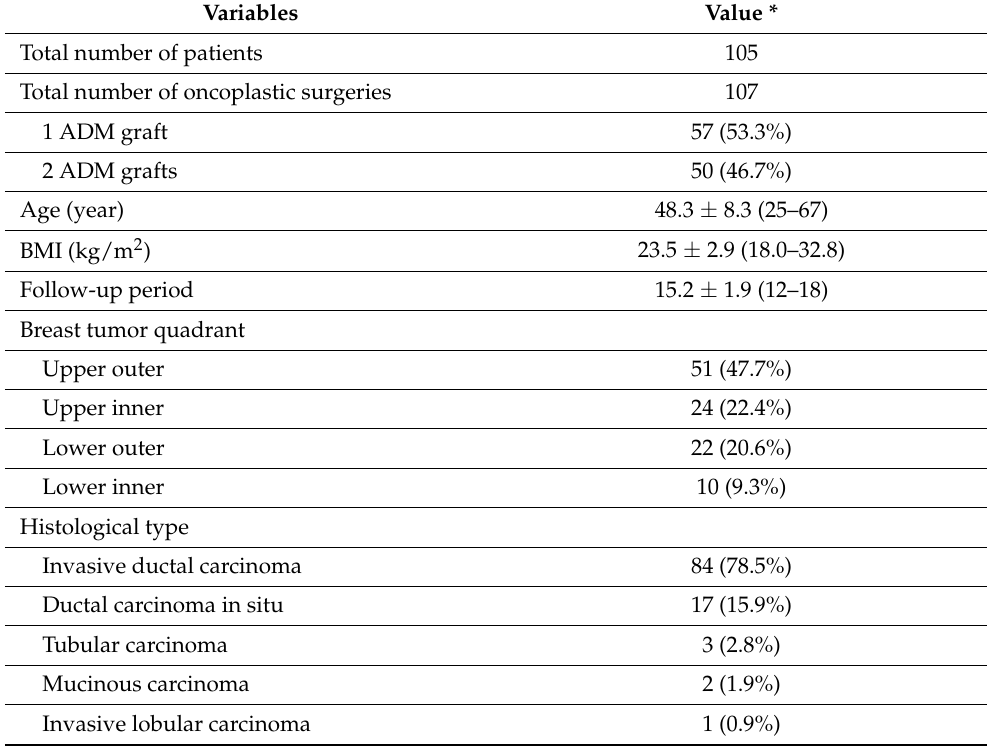
Table 1. Patients’ baseline characteristics and operative